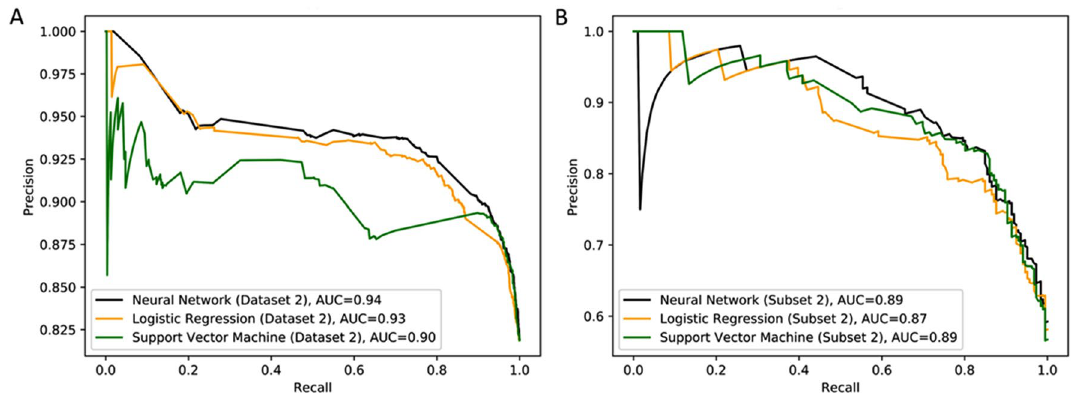
Figure 2. Precision-recall curves of machine learning models in Dataset 2 and Subset 2 using 3 features. The precision recall curves, where improved performance is demonstrated if the curve is closer to the upper right- hand corner or has the highest area under the curve (AUC), are shown for the 3 machine learning models for ( A ) the entire Dataset 2 (N = 20,198) ICU events) and ( B ) Subset 2 where SpO 2 < 97% (N = 3280 ICU events). Data was obtained from the MIMIC-III database v1.4 (https:// mimic. physi onet.